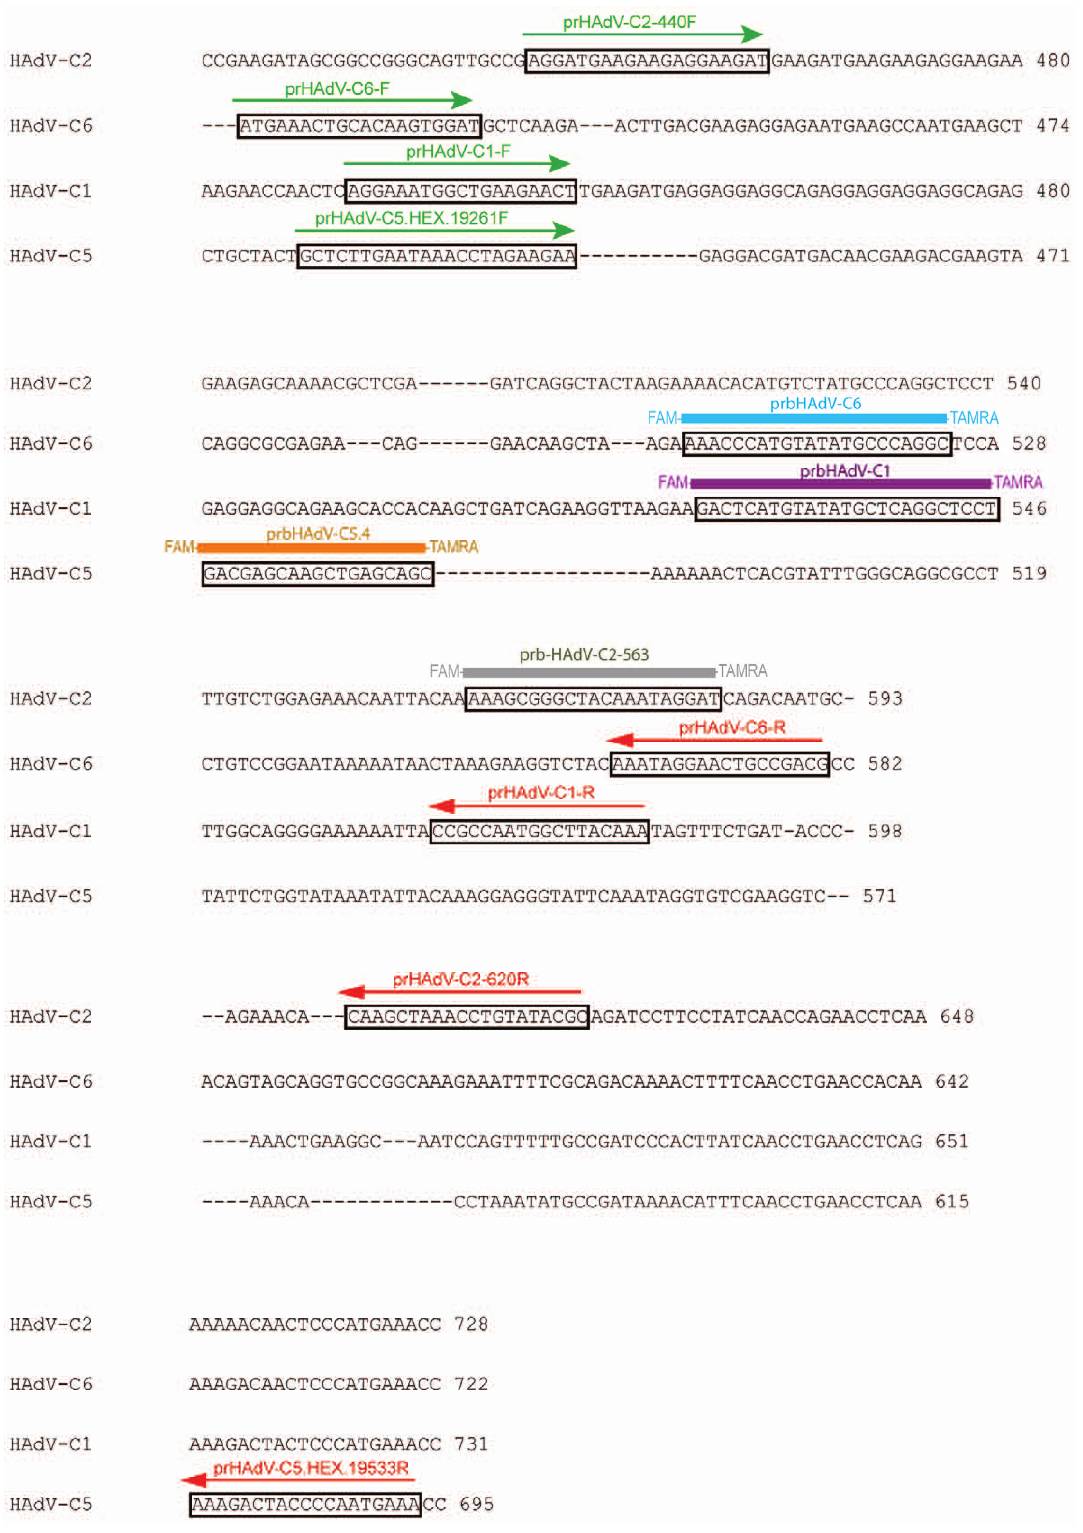
Figure 2. Primer design for type specific primer/probe pairs in species HAdV-C hexon.